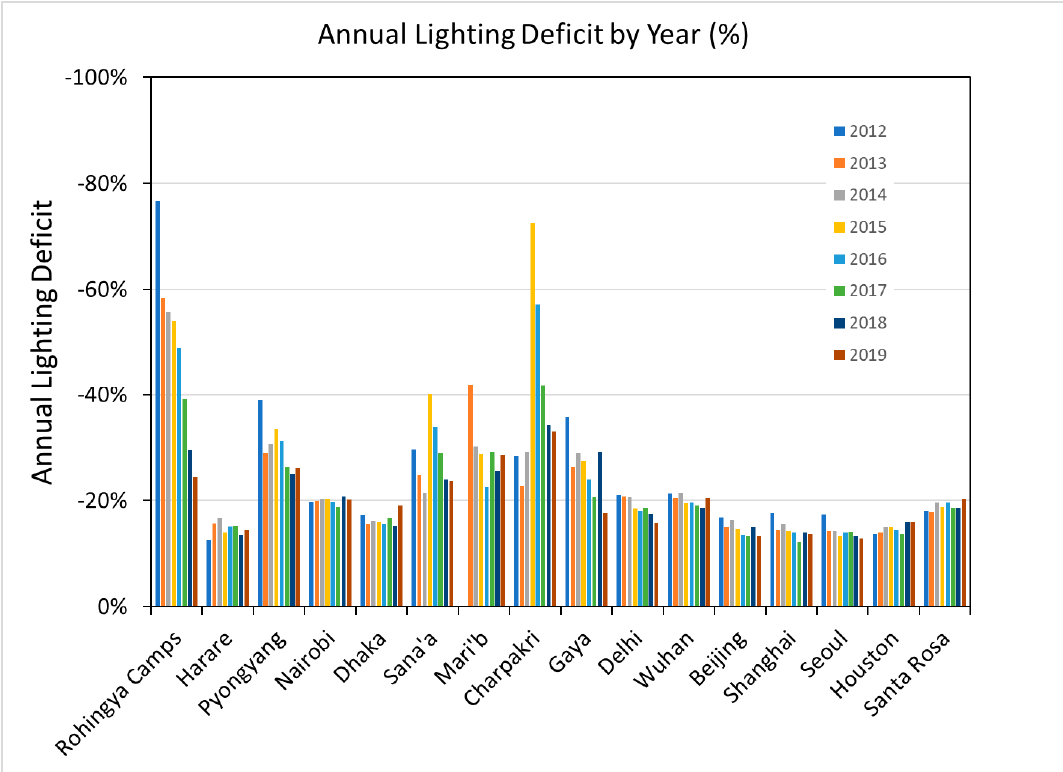
Figure 33. Picket-fence chart of the mean ALD % for each of the test sites by year.